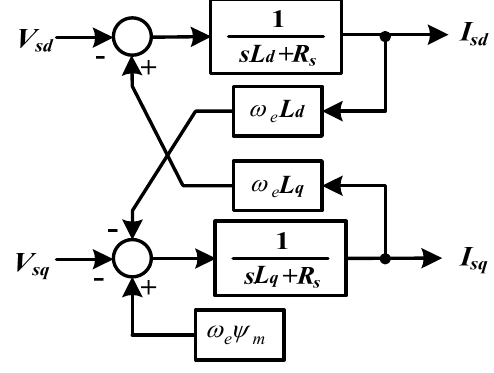
Figure 3. Block diagram of a Permanent Magnet Synchronous Generator